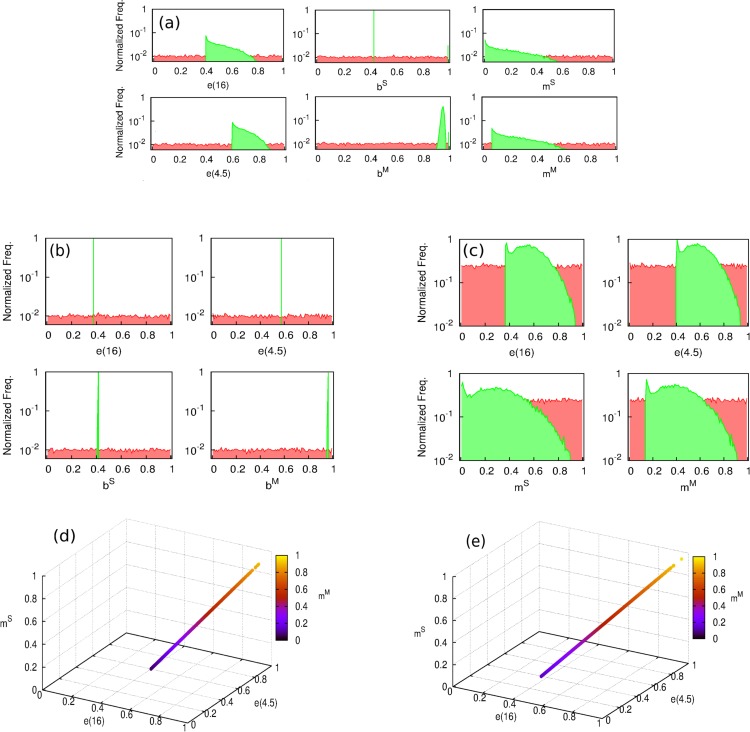
Distribution of the parameters which yield a maximum in the likelihood function.(A–C) Hill climbing algorithm distributions for models 1, 2 and 3, respectively. Starting from a series of randomly distributed points in the parameter space (their coordinates distributions are represented in red), a random displacement following a uniform distribution in the parameter space within a hyper-cube of size d = 0.001 is attempted at each time step, and accepted only if it corresponds to an increasing of the likelihood function \documentclass[12pt]{minimal}
\usepackage{amsmath}
\usepackage{wasysym}
\usepackage{amsfonts}
\usepackage{amssymb}
\usepackage{amsbsy}
\usepackage{upgreek}
\usepackage{mathrsfs}
\setlength{\oddsidemargin}{-69pt}
\begin{document}
}{}$L(\vec{P})$\end{document}LP→. The algorithm stops when no further move is accepted after N = 107 rejected displacements (i.e., the function \documentclass[12pt]{minimal}
\usepackage{amsmath}
\usepackage{wasysym}
\usepackage{amsfonts}
\usepackage{amssymb}
\usepackage{amsbsy}
\usepackage{upgreek}
\usepackage{mathrsfs}
\setlength{\oddsidemargin}{-69pt}
\begin{document}
}{}$L(\vec{P})$\end{document}LP→ reaches a maximum). In green, we see the peaked distribution of the end points of the algorithm around the solution of the models. (D and E) parameters cliff yielding quasi-constant values of maximum likelihood \documentclass[12pt]{minimal}
\usepackage{amsmath}
\usepackage{wasysym}
\usepackage{amsfonts}
\usepackage{amssymb}
\usepackage{amsbsy}
\usepackage{upgreek}
\usepackage{mathrsfs}
\setlength{\oddsidemargin}{-69pt}
\begin{document}
}{}$L({\vec{P}}^{\ast })=0.79$\end{document}LP→∗=0.79 for model 1 and \documentclass[12pt]{minimal}
\usepackage{amsmath}
\usepackage{wasysym}
\usepackage{amsfonts}
\usepackage{amssymb}
\usepackage{amsbsy}
\usepackage{upgreek}
\usepackage{mathrsfs}
\setlength{\oddsidemargin}{-69pt}
\begin{document}
}{}$L({\vec{P}}^{\ast })=0.002$\end{document}LP→∗=0.002 for model 3. As it can be seen in (A) and (D), the model versions that contemplate masking are unable to provide a clear univocal vaccine description yielding maximum likelihood. The reason for this behavior is the existence of a region in the parameters space, represented in (D) and (E), within which, likelihood is almost constant and close to its absolute maximum.